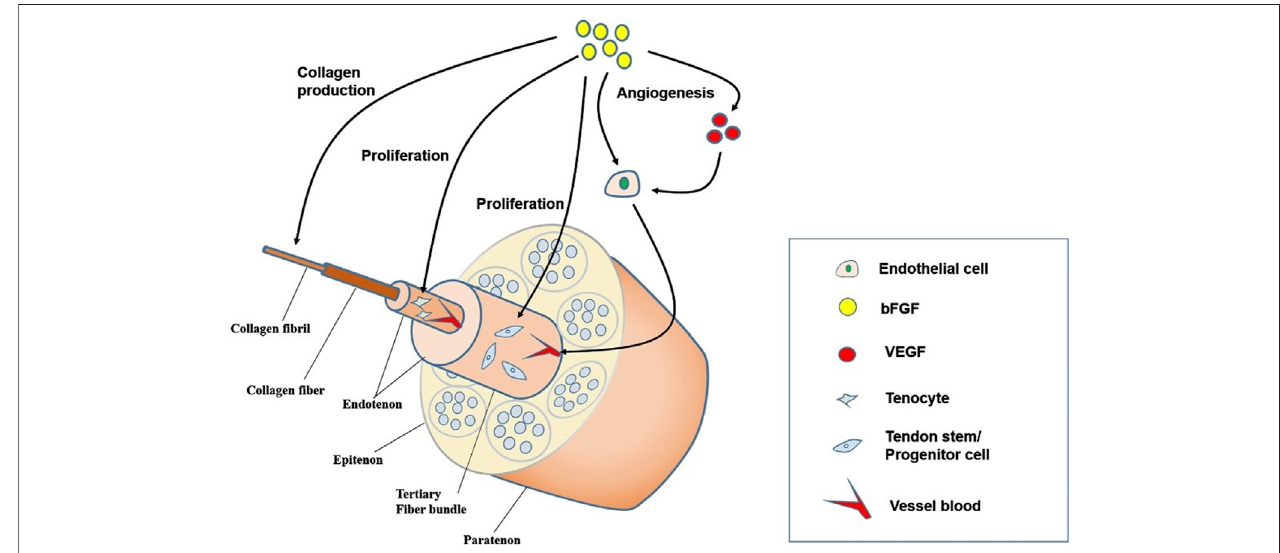
FIGURE2| MechanismsoftheroleofbFGFintheprocessoftendonhealing.bFGFpromotesangiogenesis,TSCsandtendoncellproliferation,aswellascollagen production, thereby promoting tendon repair. bFGF, Basic fi broblast growth factor; VEGF, vascular endothelial growth factor; TSCs, tendon stem cells.